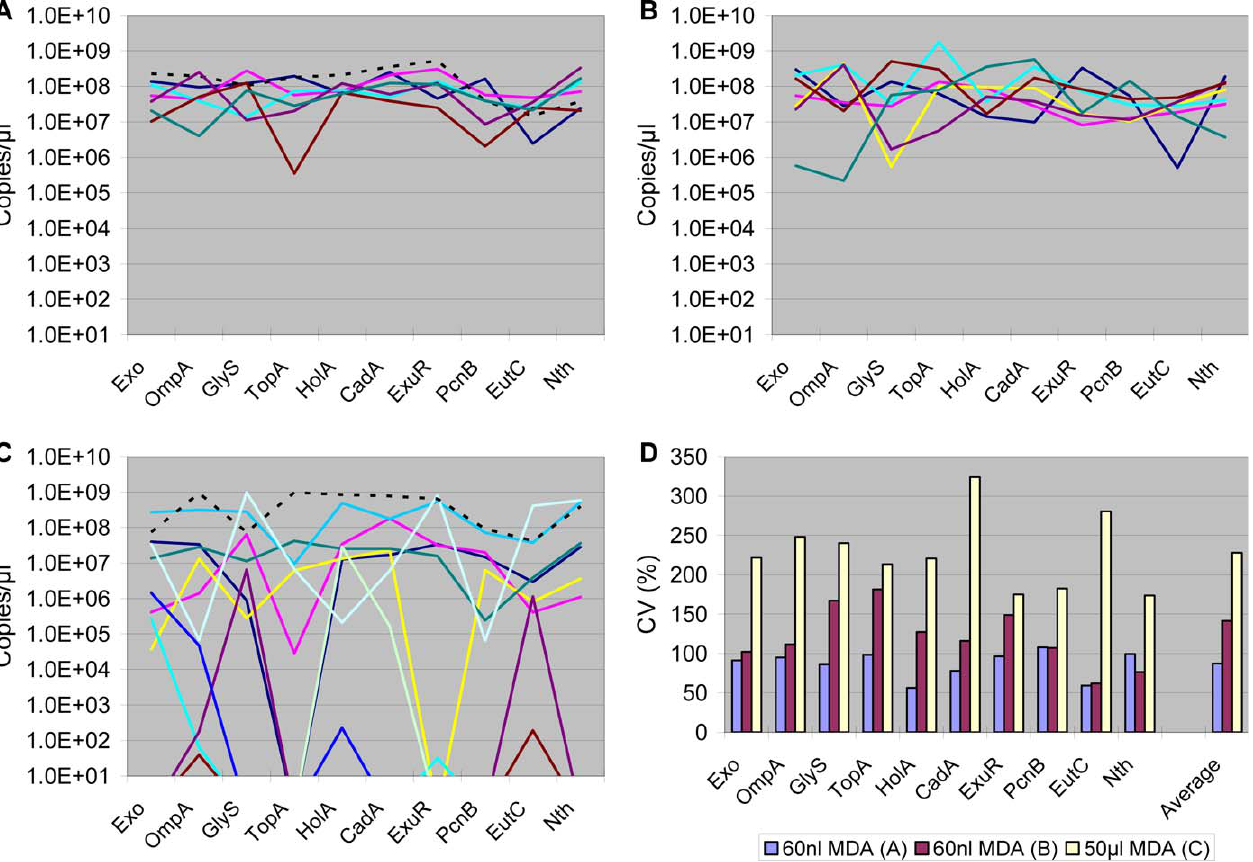
Figure 3. Quantitative PCR Analysis by TaqMan Assay for Representation of Ten Loci in Single-Cell Amplifications Each line represents one MDA reaction from two series of 60-nl microfluidics amplifications (A and B) and 50- l l control amplifications (C). The lower limit (10 copies/ l l) of the figures corresponds to the detection limit of the TaqMan assay. Dotted lines in (A) and (C) represent the amplifications selected for sequencing. (D) Coefficient of variance (CV) for the seven 60-nl MDA reactions in panel (A), seven 60-nl MDA reactions in panel (B), and 12 50- l l control MDA reactions in panel (C). The average of the ten loci for the two series of 60-nl microfluidics amplifications and 50- l l control amplifications are indicated at the right.